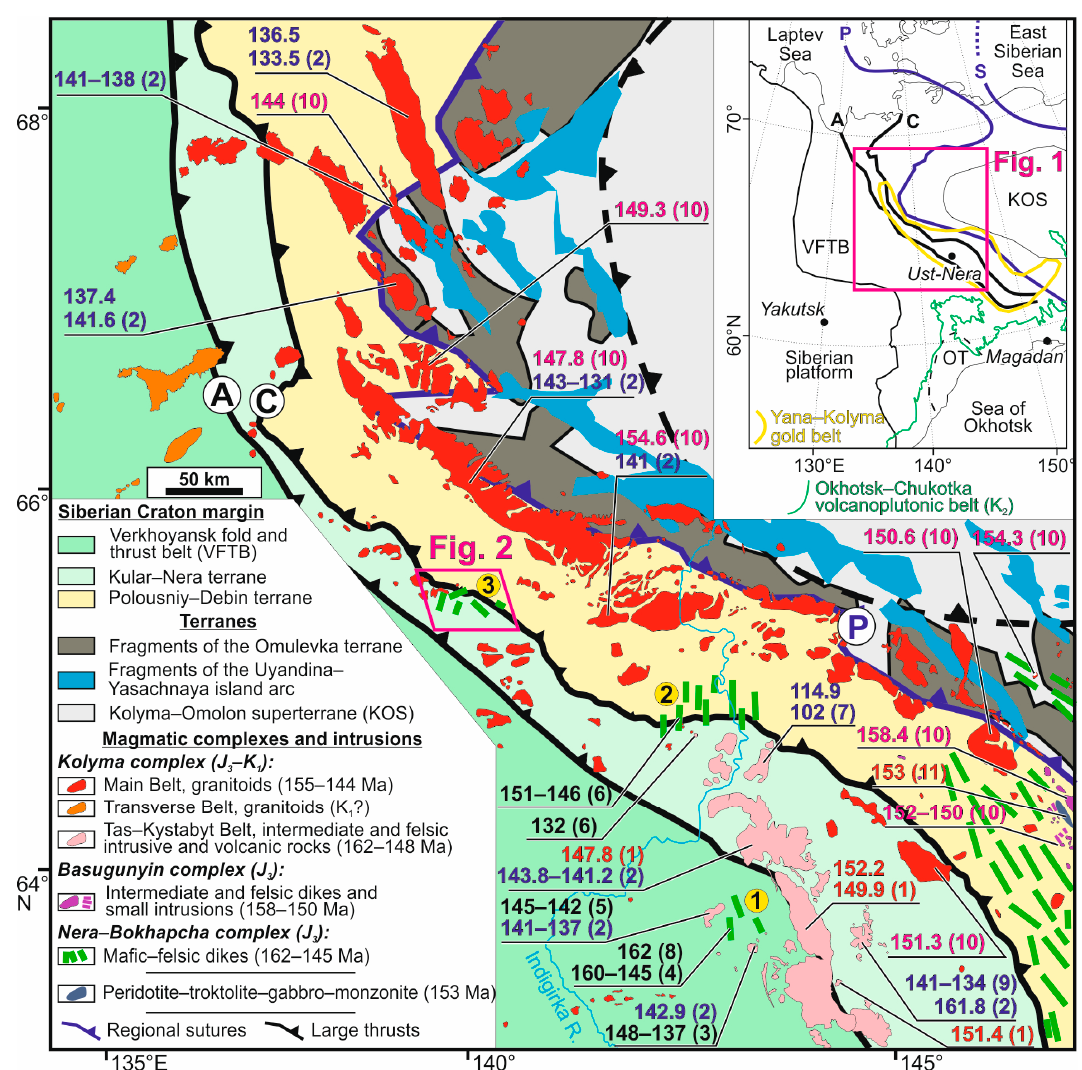
Figure 1. Geology of the central part of the Verkhoyansk–Kolyma folded area with the main tectonic units, Jurassic–Cretaceous magmatism, and sites of investigations. Compiled using [6,39,43]. Colored